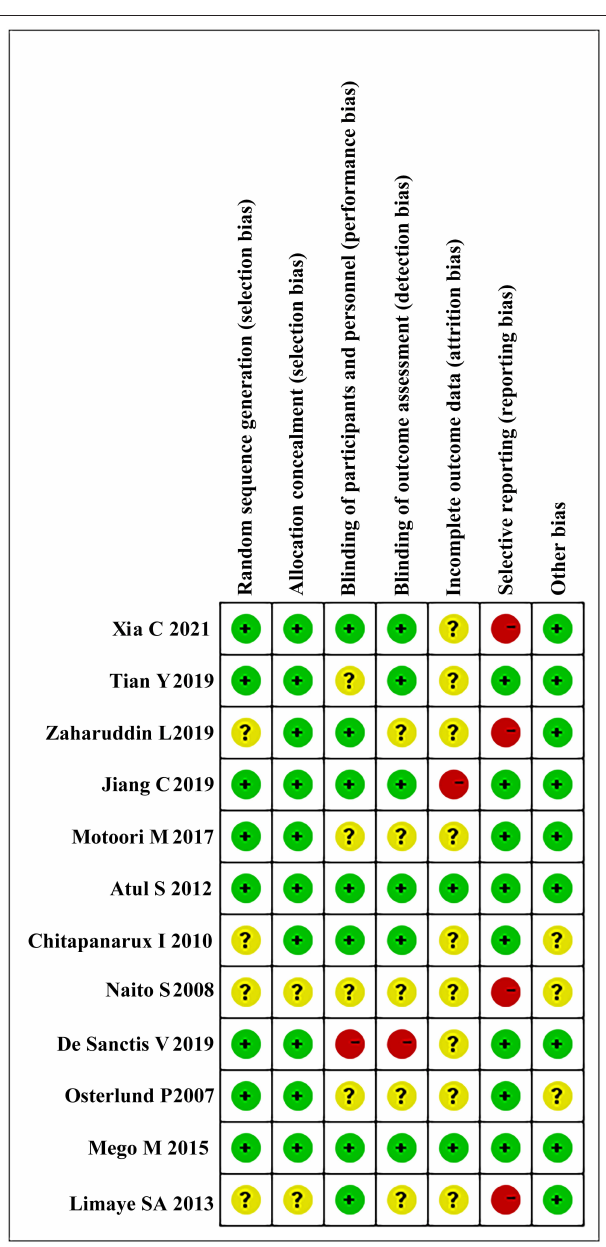
FIGURE 2 | Risk of bias graph for each included